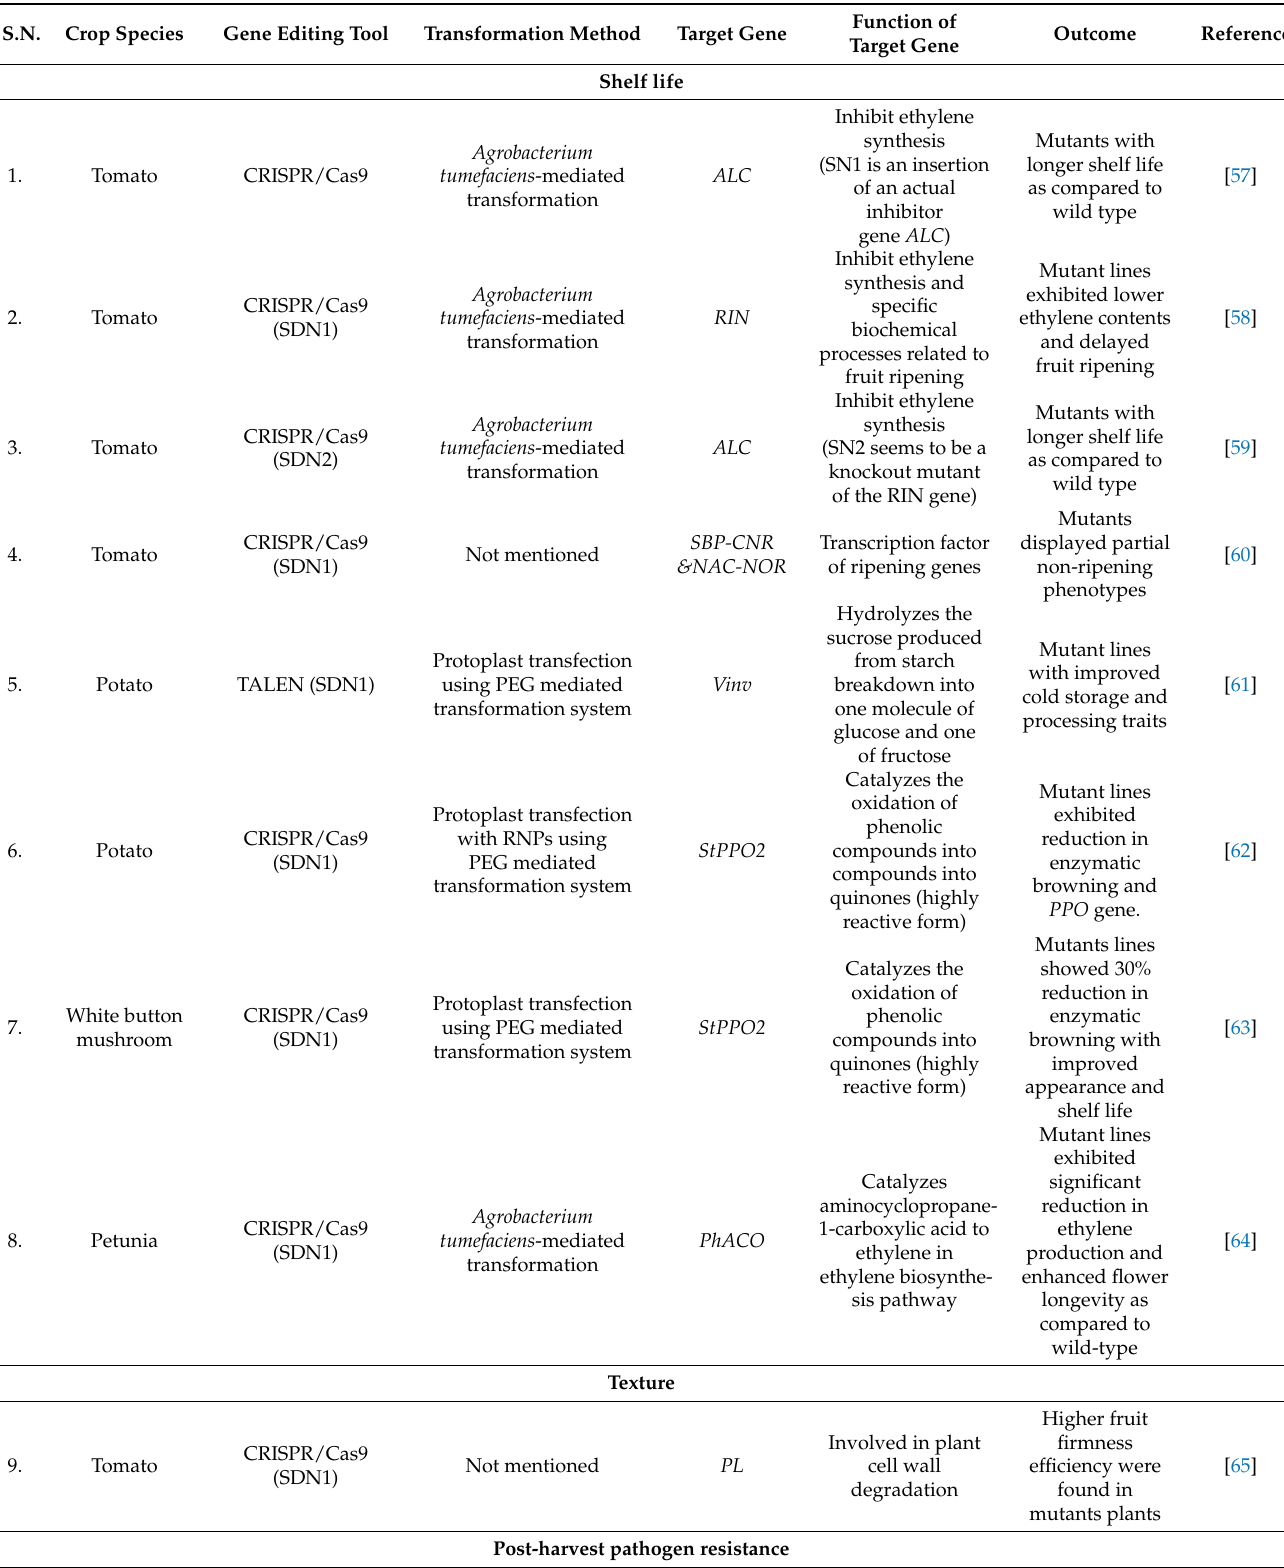
Table 1. Application of genome editing techniques in horticultural crops to improve their post-harvest quality and